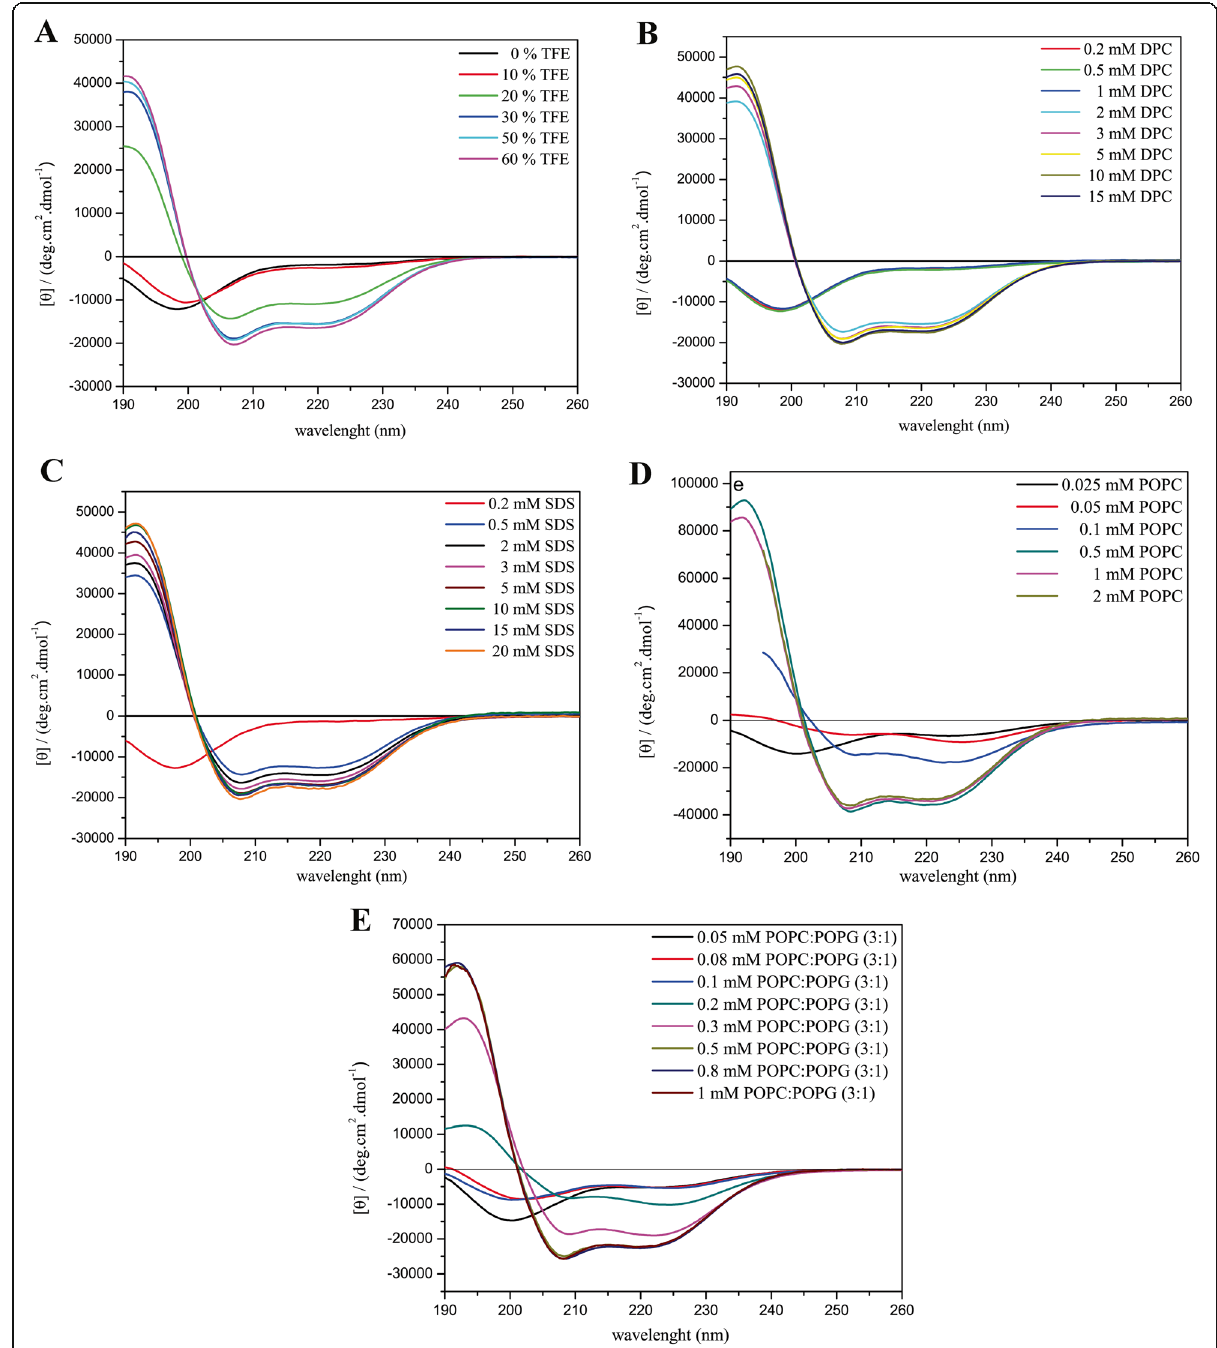
Fig. 5 CD spectra of ocellatin-LB1 in the presence of ( a ) TFE:H 2 O solutions, ( b ) DPC and ( c ) SDS micelles, ( d ) POPC and ( e ) POPC:POPG (3:1)